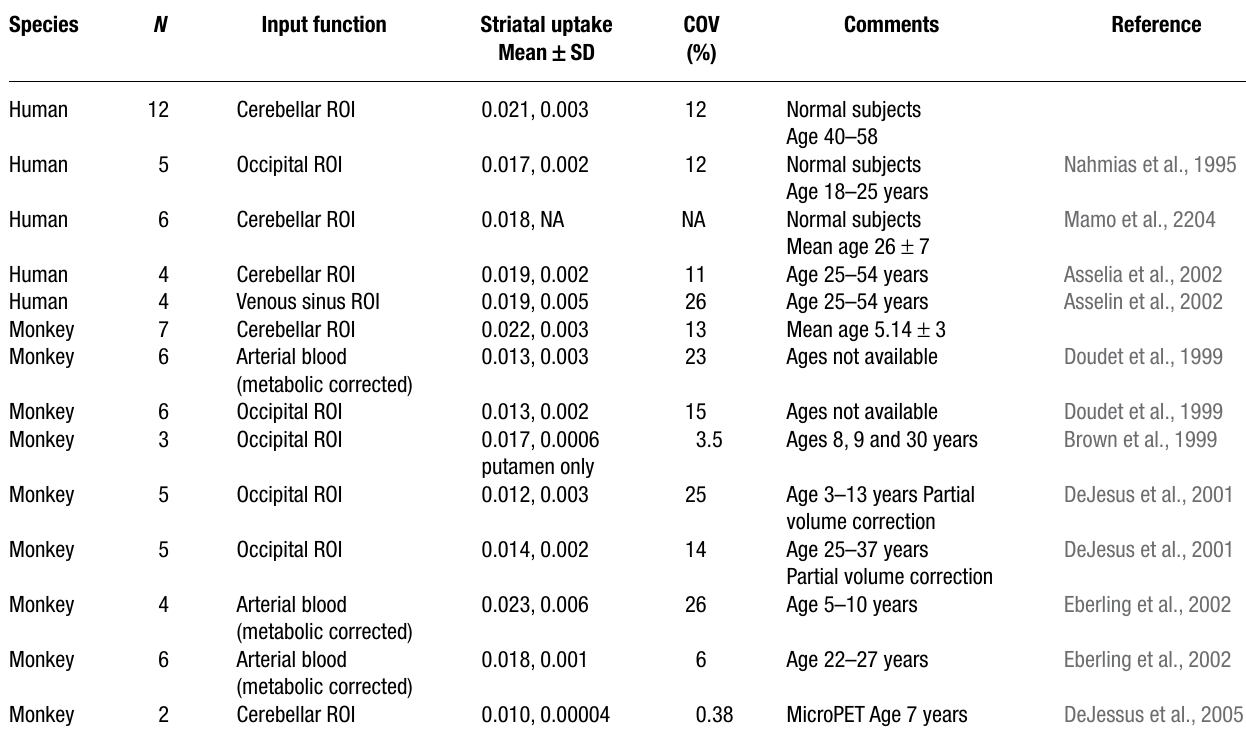
Table 1. FMT uptake values in normal humans and monkeys.